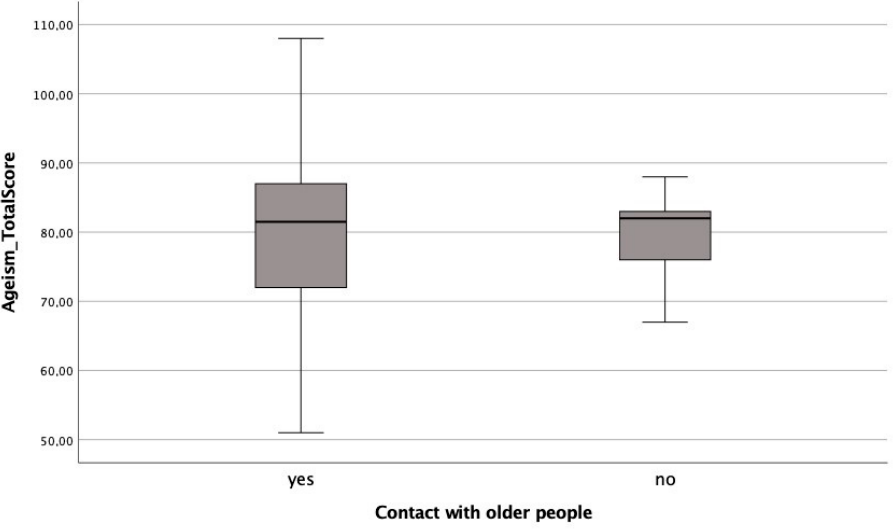
Figure 3. A box plot of the relationship between the total ageism score and the participants’ contact with older adults .